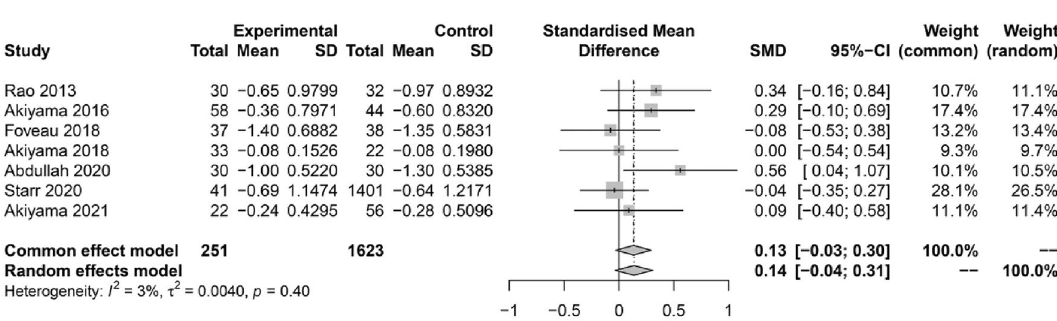
Figure 3. Forest plot showing the standardized mean difference (SMD) and 95% confidence intervals (CI) for BCVA change.